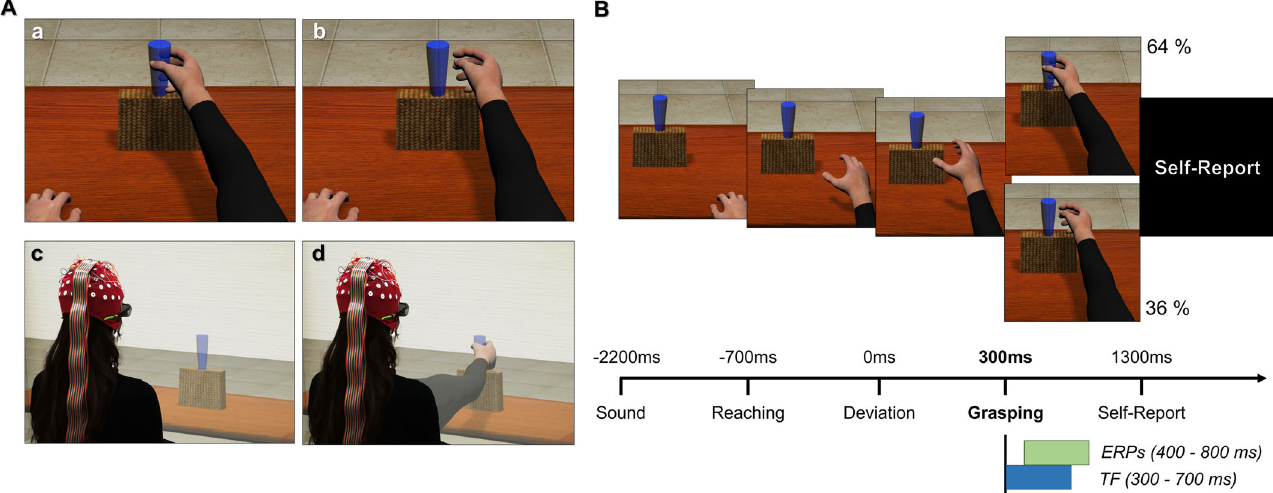
Fig. 6 Schematic representation of the experimental paradigm and setup. A Images (c) and (d) show the participant immersed in a virtual scenario in the CAVE system while observing the real-size virtual arm from a 1PP during a correct (a) or erroneous (b) grasping action. B The timeline of a single trial. The avatar ’ s action lasted ~1000 ms, with the reaching phase equal for both outcomes. The onset of the avatar ’ s arm- path deviation is at 0 ms, and the end of the avatar ’ s action occurs at 300 ms. The time windows for event-related potential (ERPs) and time- frequency (TF) analyses have been chosen a priori based on previous studies 30,58